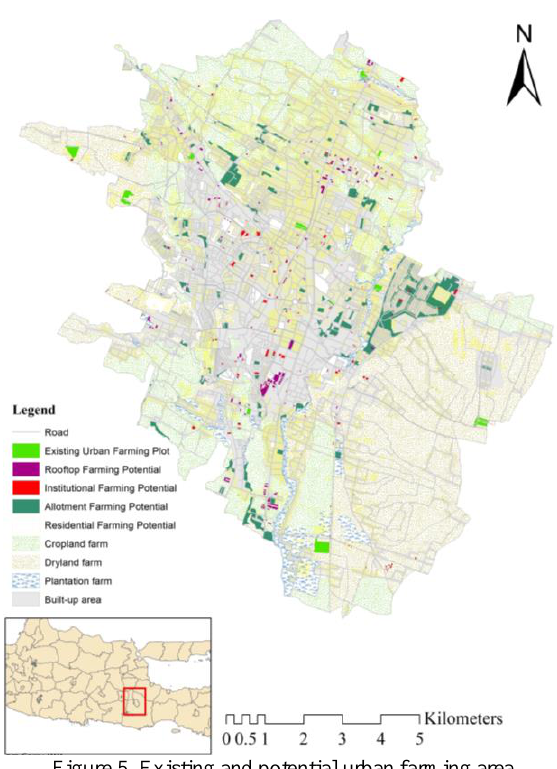
Figure 5. Existing and potential urban farming area